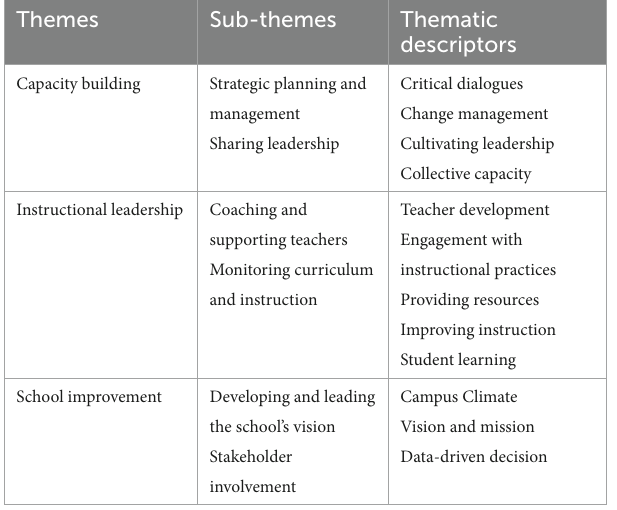
TABLE 5 Reflections through online discussions within VPLC: cycles of